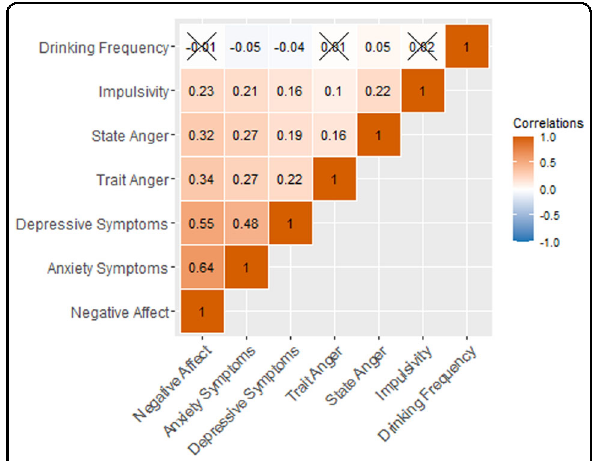
Fig. 1 Within- and across-domain correlations among phenotypes in the Health and Retirement Study. 5873 < N < 5965. Associations that were not signi fi cant at p < 0.05 are marked with an “ X ”